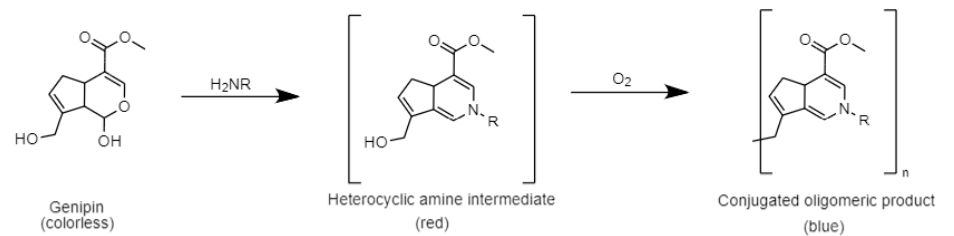
Figure 1. Schematic mechanism of genipin reaction in presence of